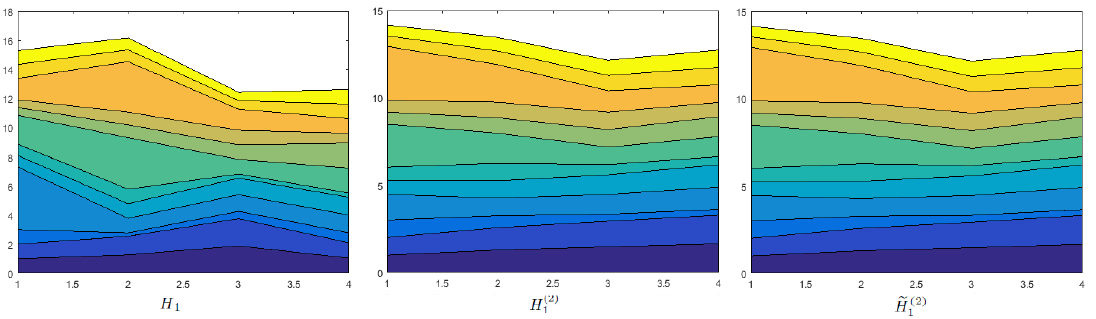
Figure 8. Area graphs of score values of H 1 .